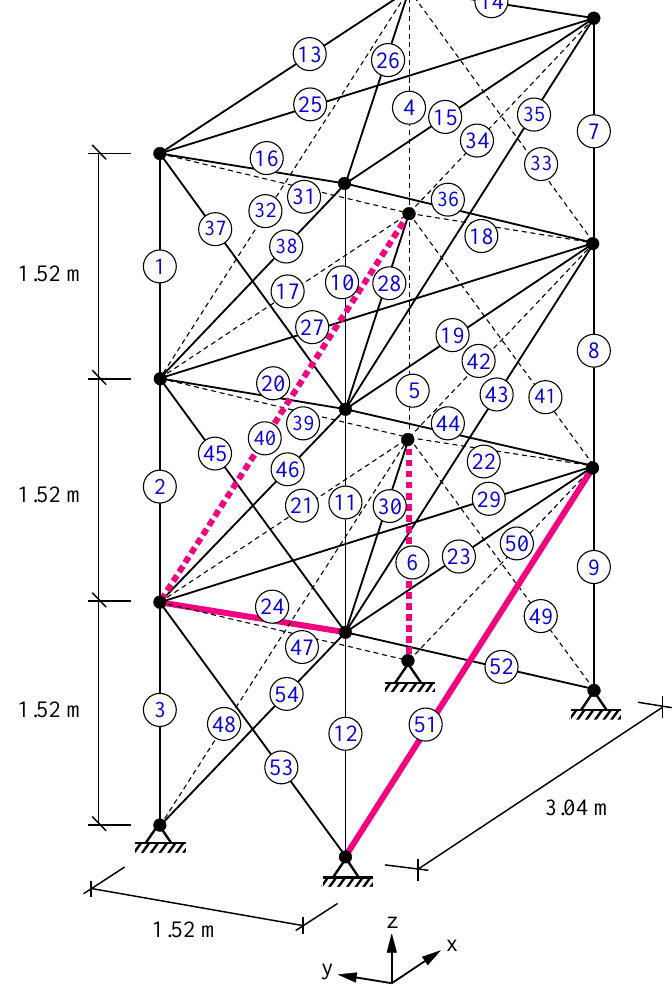
Figure 8. A 54-bar space truss.